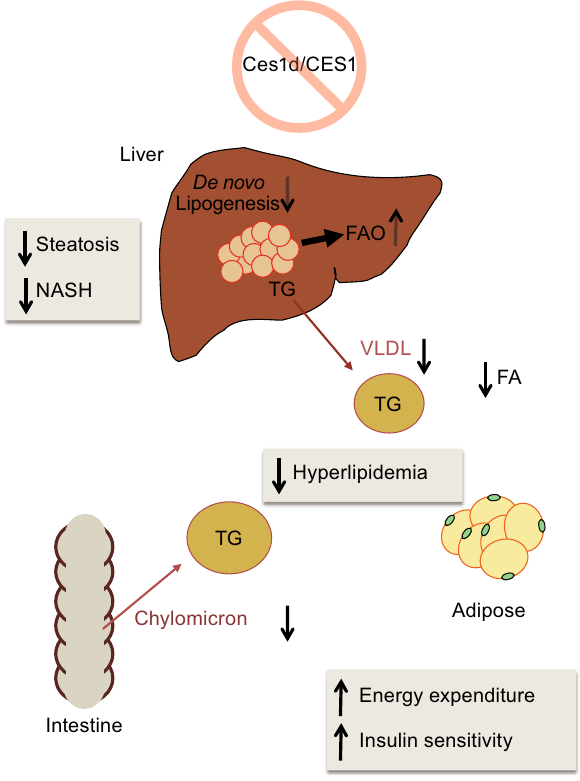
Figure 4. Effects of Ces1g de fi ciency on lipid and energy